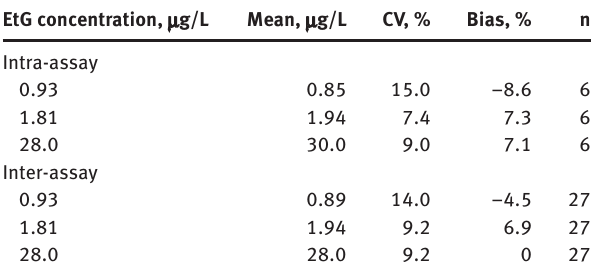
Table 2: Analytical imprecision and accuracy of EtG measurement in whole blood.